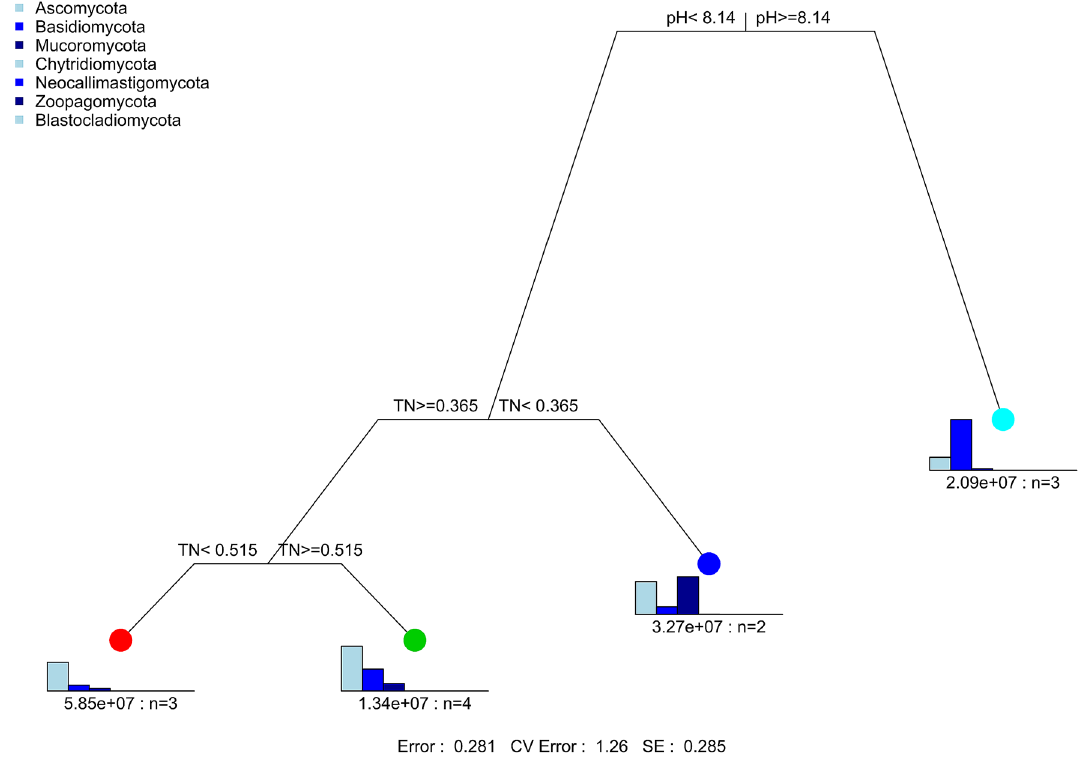
Figure 4. The multivariate regression tree (MRT) was used to reveal the relationship of relative abundance of core phyla with change in soil properties caused by KRD progression. Soil organic matter (SOM) and total phosphorus (TP).